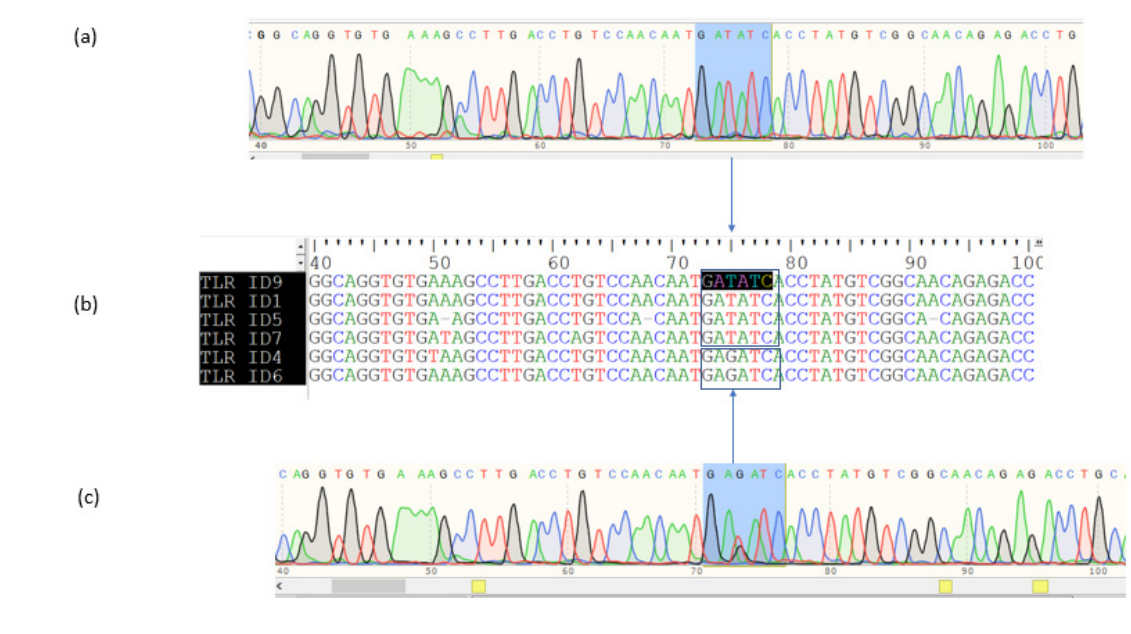
Figure 3. Alignment of the sequence of PCR products for the TLR2 gene. ( a ): The sequences of animals (9, 1, 5, and 7) with TT genotypes; ( b ): The alignment of PCR products for the TLR2 gene for six animals; ( c ): The sequences of animals (4 and 6) with GG or GT genotypes. The blue mark indicated a recognizing sequence of the restriction enzyme, and the error showed the TLR2 alleles (T or G) on this sequence. Table 5. Association between milk components with the Toll-like receptor 2 (TLR2) genotypes and interactions between Toll-like receptor 2 genotypes and mastitis.